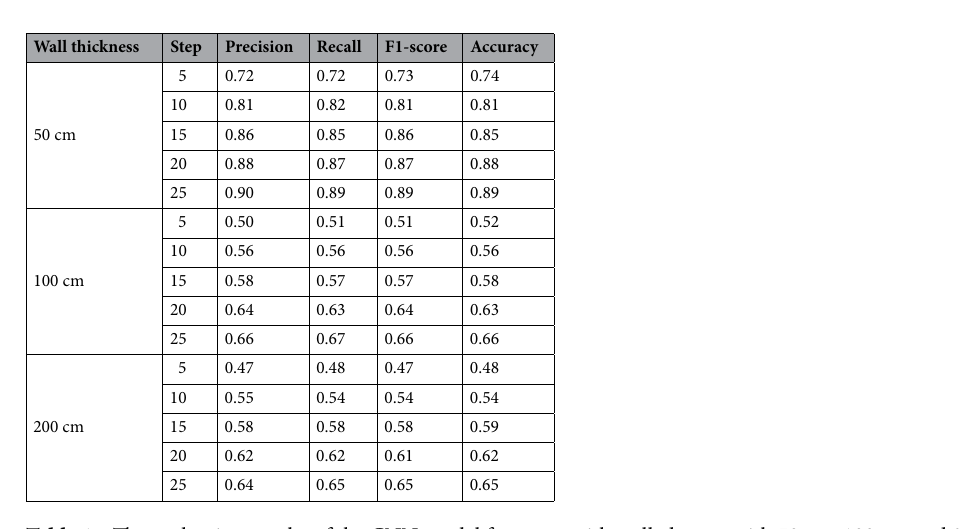
Table 1. The evaluation results of the CNN model for room with walled maze with 50 cm, 100 cm and 200 cm thickness.